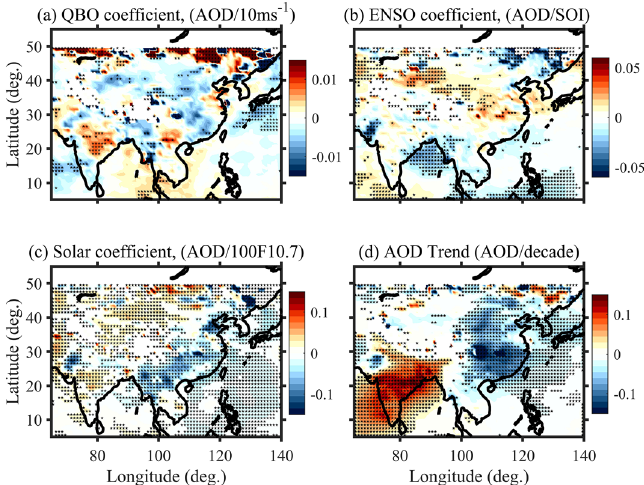
Figure 2. ( a ) QBO coefficient, ( b ) ENSO coefficient, ( c ) solar cycle coefficient obtained from the regression analysis applied on AOD measured by MODIS during 2001–2018. ( d ) Trends in AOD after removing the long- period oscillation contribution. Star marks show the trend that is statistically significant at 95% confidence level. The maps were created by using MATLAB software R2019b with mapping tool box (see https ://in.mathw orks. com/produ cts/new_produ cts/relea se201 9b.html and https ://www.mathw orks.com/produ cts/mappi